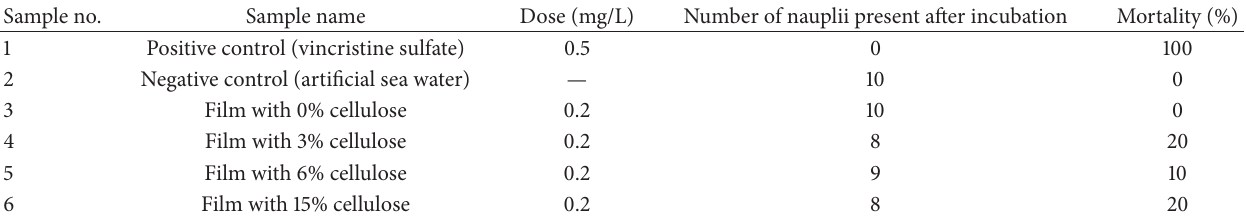
Table 2: Mortality of brine shrimp ( Artemia salina ) nauplii at different concentrations of cellulose/PLA thin film. Sample